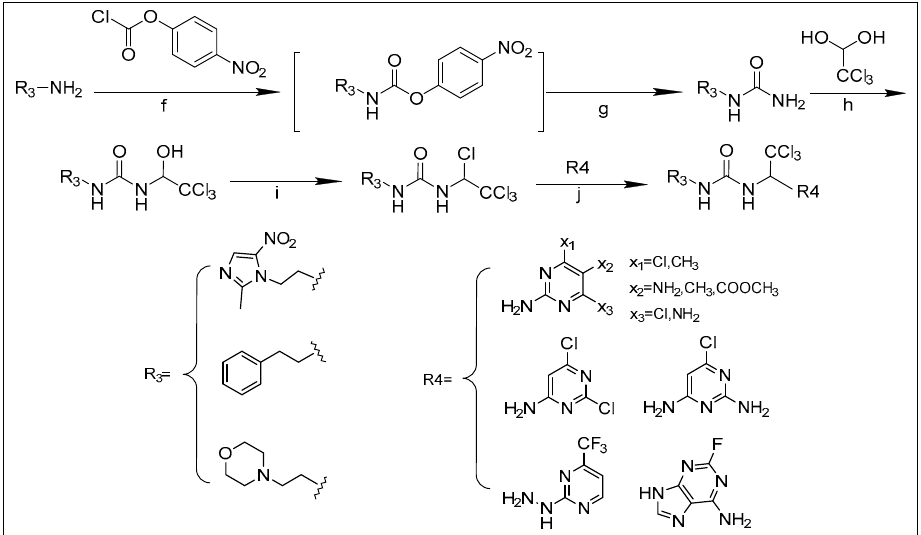
Table 1. Structures of synthesized